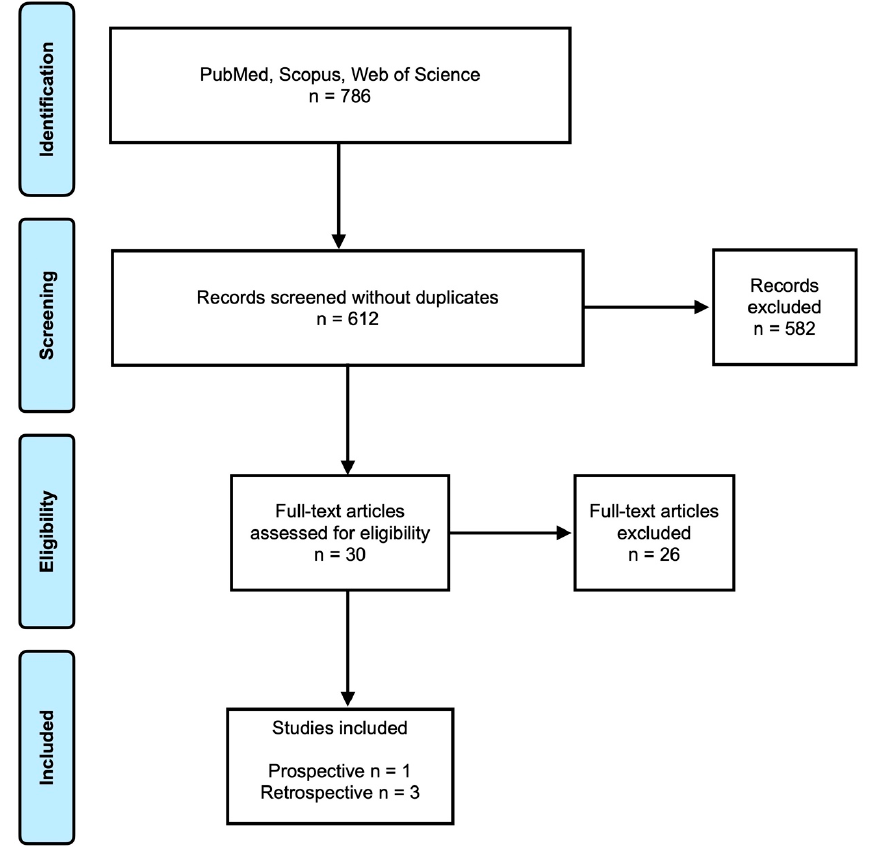
Figure 1. PRISMA flow chart.